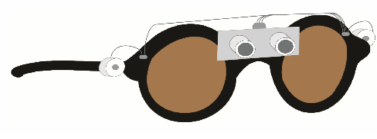
Figure 3. Ultrasonic smart glasses